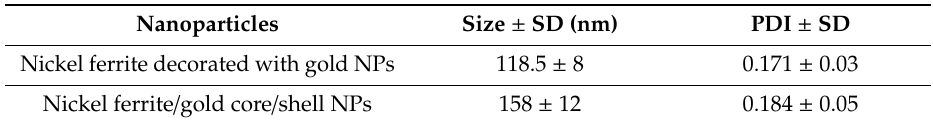
Table 3. Size and polydispersity of solid magnetoliposomes (SMLs) determined by dynamic light scattering (DLS) (SD: standard deviation; PDI: polydispersity